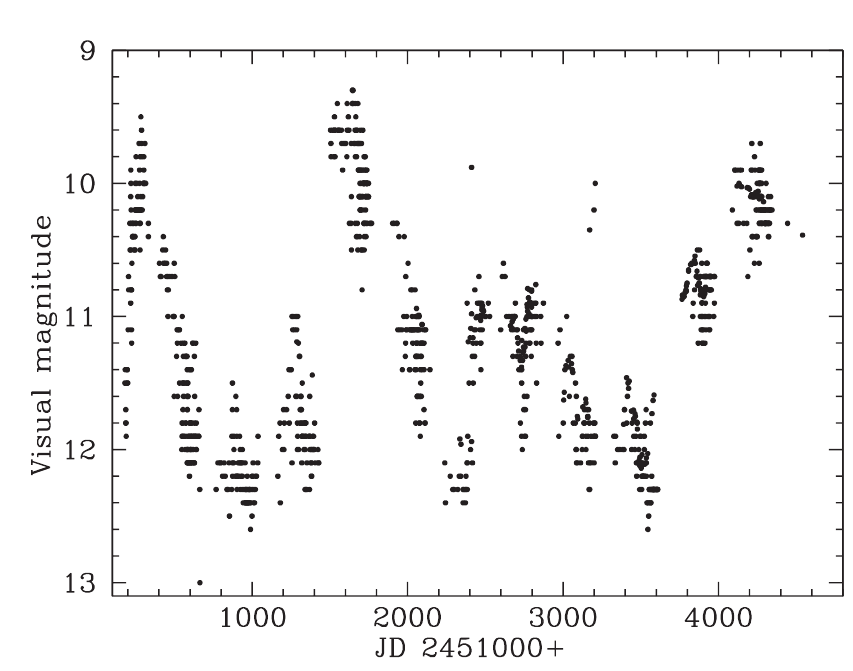
Fig. 5. The visual light curve of BX